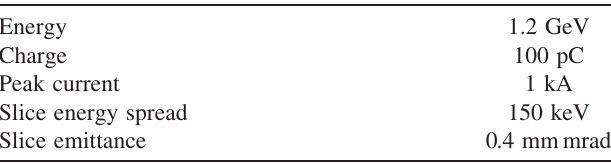
TABLE I. Electron beam parameters. Energy 1.2 GeV Charge 100 pC Peak current 1 kA Slice energy spread 150 keV 2 FODO lattice indicates periodic focusing structure with the Slice emittance 0.4 mm mrad period: focusing quadrupole, drift, defocusing quadrupole,